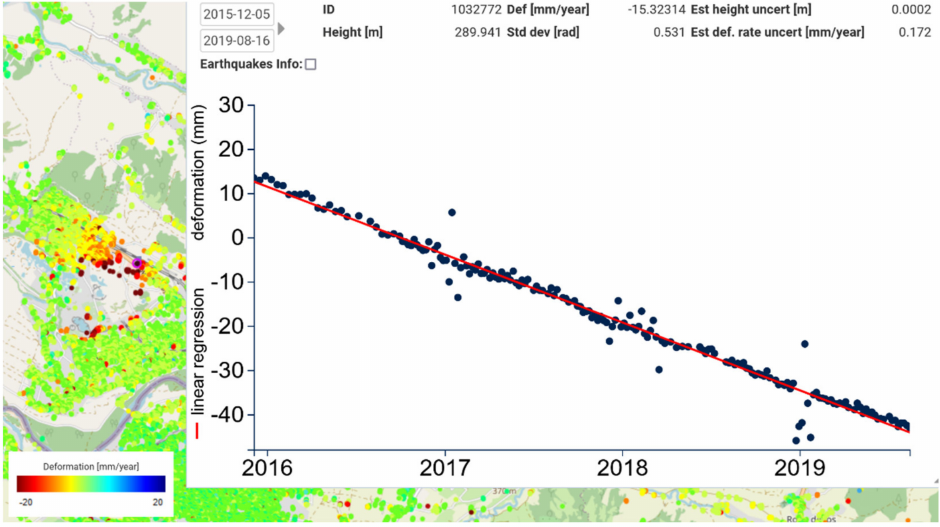
Figure 10. Ground subsidence related to salt exploitation in Solotvyno,